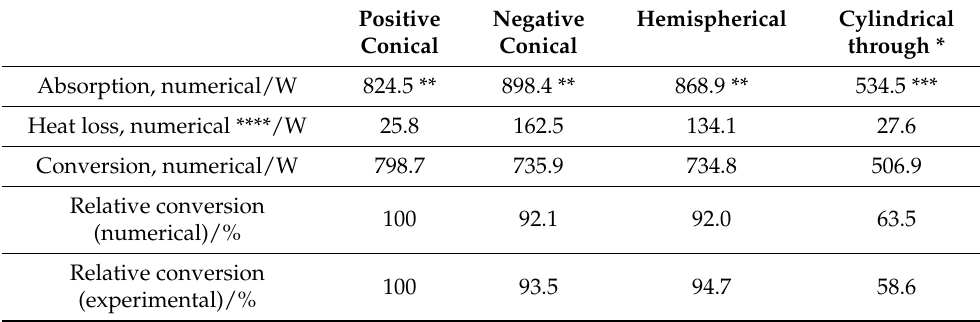
Table 9. Relative power conversion (% of positive conical cavity). Positive